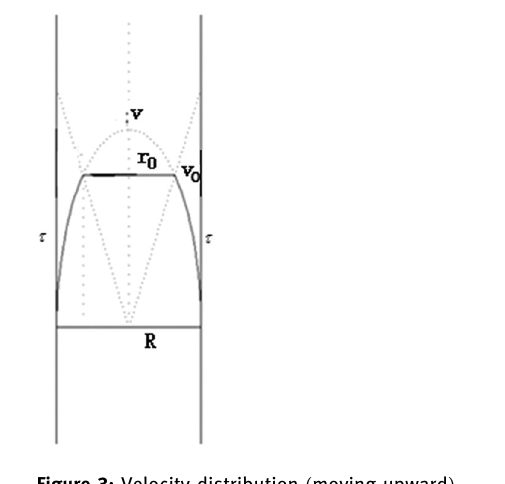
Figure 3: Velocity distribution ( moving upward ) provide negative pressure in a vacuum pump; ( 2 ) flow